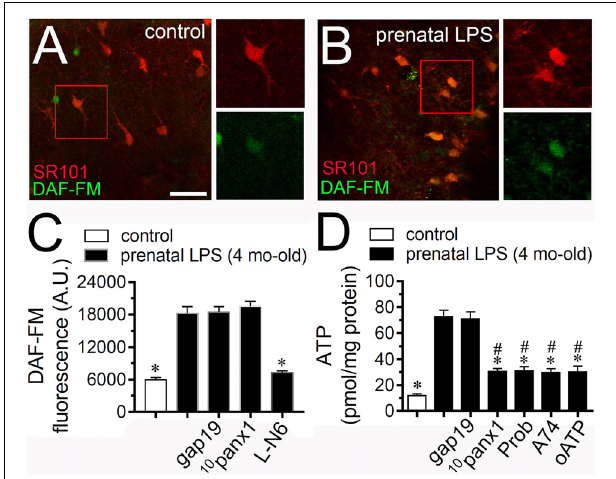
FIGURE 3 | Prenatal LPS exposure increases the production of NO by astrocytes and the Panx1 channel-dependent release of ATP on offspring hippocampus. Representative images showing SR101 (red) and DAF-FM (green) staining by hippocampal astrocytes in acute slices from control offspring (A) or prenatally LPS-exposed offspring (B) of 4 months old. Insets of astrocytes were taken from the area depicted within the red squares in (A,B) . (C) Averaged of DAF-FM signal fluorescence by astrocytes in acute slices from control offspring (white bar) or prenatally LPS-exposed offspring of 4 months old alone (black bars) or in combination with the following pharmacological agents: 100 µ M gap19, 100 µ M 10 panx1 and 1 µ M L-N6. ∗ p < 0.0001 versus LPS, one-way ANOVA Tukey’s post hoc test, mean ± S.E.M., n = 3. (D) Averaged data of ATP release by acute hippocampal slices from control offspring (white bar) or prenatally LPS-exposed offspring of 4 months old alone (black bars) or in combination with the following blockers: 100 µ M gap19, 100 µ M 10 panx1 and 1 µ M L-N6. ∗ p < 0.0001 versus LPS, # p < 0.0001 versus control, one-way ANOVA Tukey’s post hoc test, mean ± S.E.M., n = 3. Calibration bar = 85 µ